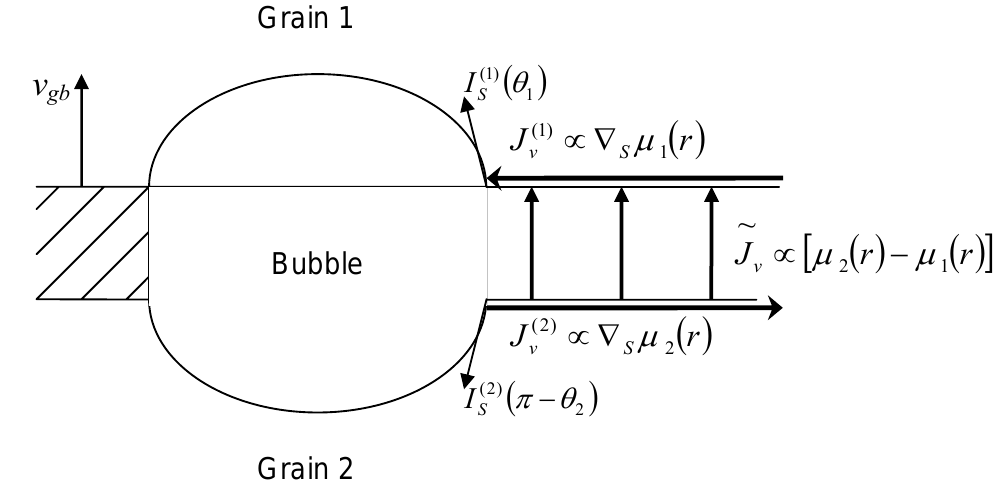
Figure 4. Schematic representation of vacancy fluxes along and across the grain